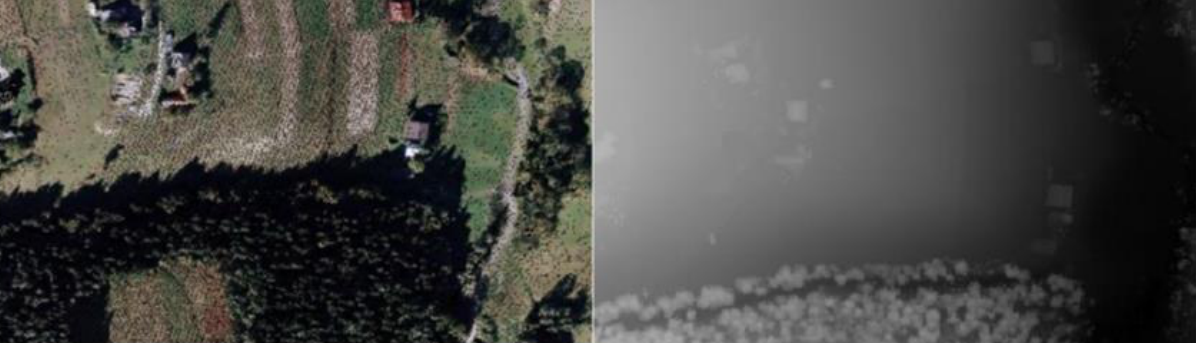
Figure 12. The Model keypoints for the entire area.